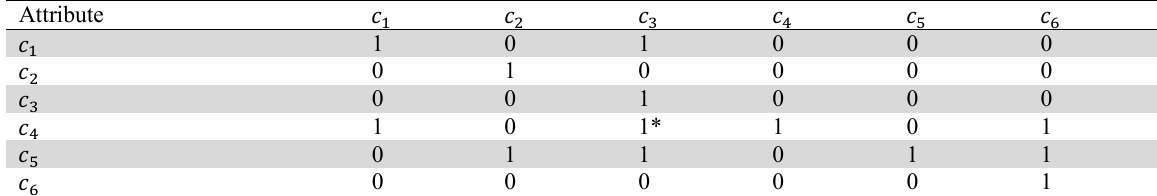
Final reachability matrix for supplier evaluation problem